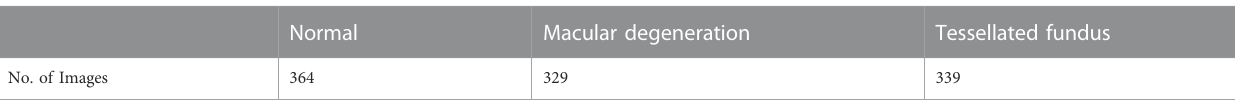
TABLE 1 Statistics of our dataset in each